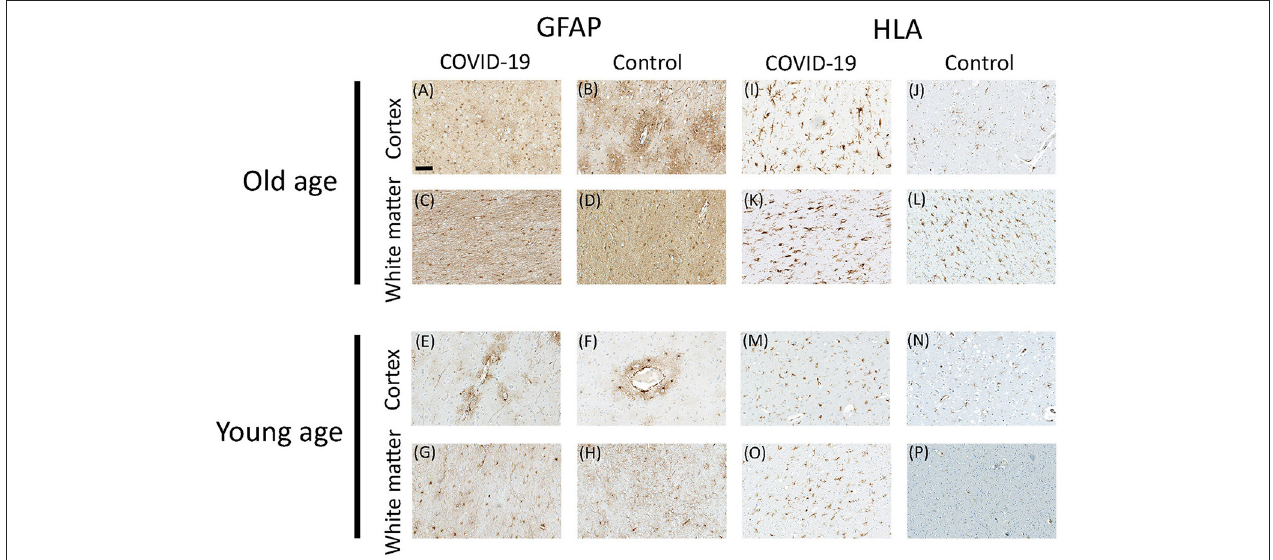
FIGURE 3 | Representative microscopic images for GFAP and HLA immunostaining in COVID-19 patients and controls. GFAP staining in cortex (A,B) and white matter (C,D) of old COVID-19 patients and controls; and GFAP staining in cortex (E,F) and white matter (G,H) of young COVID-19 patients and controls. HLA staining in cortex (I,J) and white matter (K,L) of old COVID-19 patients and controls; and HLA staining in cortex (M,N) and white matter (O,P) of young COVID-19 patients and controls. Scale bar = 100 µ